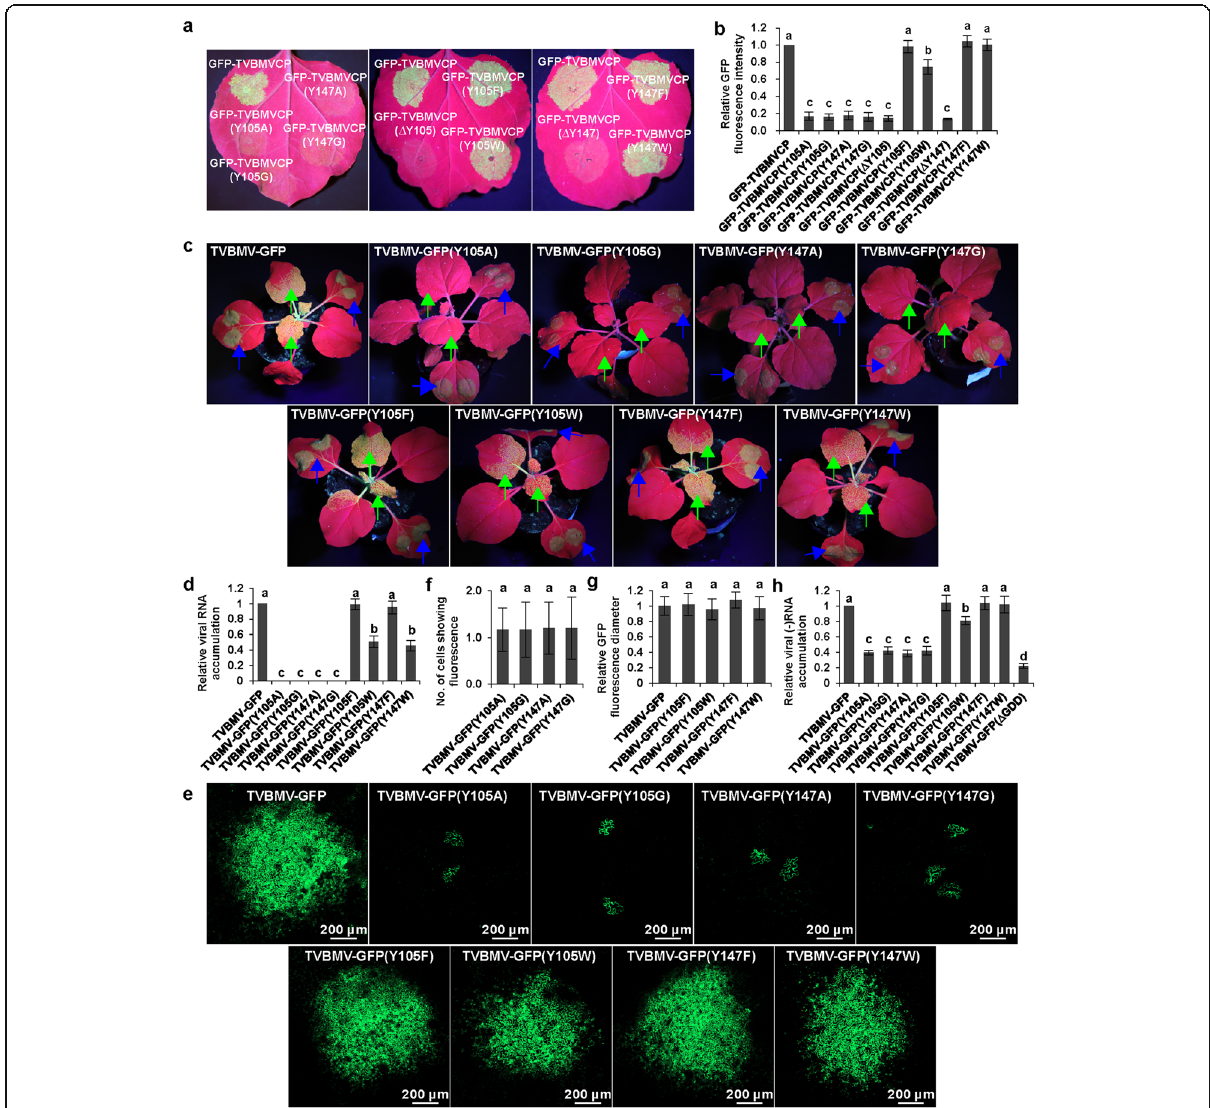
Fig. 4 Effects of substitution retaining π -stackings on CP accumulation, replication and movement of TVBMV. a GFP fluorescence and b relative GFP fluorescence intensities in the N. benthamiana leaf patches expressing GFP-TVBMVCP, GFP-TVBMV(Y105A), GFP-TVBMV(Y105G), GFP- TVBMV(Y147A), GFP-TVBMV(Y147G), GFP-TVBMVCP ( Δ Y105), GFP-TVBMVCP(Y105F), GFP-TVBMVCP(Y105W), GFP-TVBMVCP ( Δ Y147), GFP- TVBMVCP(Y147F) and GFP-TVBMVCP(Y147W) at 5 dpai. Pictures were photographed under UV light. GFP fluorescence intensities were determined by a multi-function microplate reader. ‘ Δ ’ indicates the codon for the residue has been deleted. c GFP fluorescence and d viral RNA